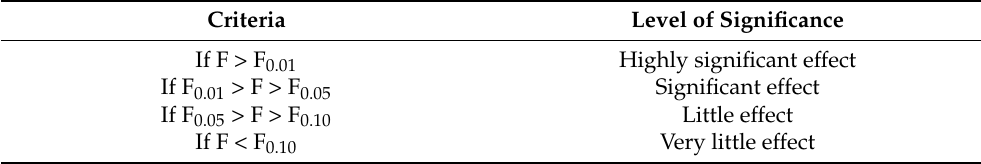
Table 3. Criteria of significant analysis.